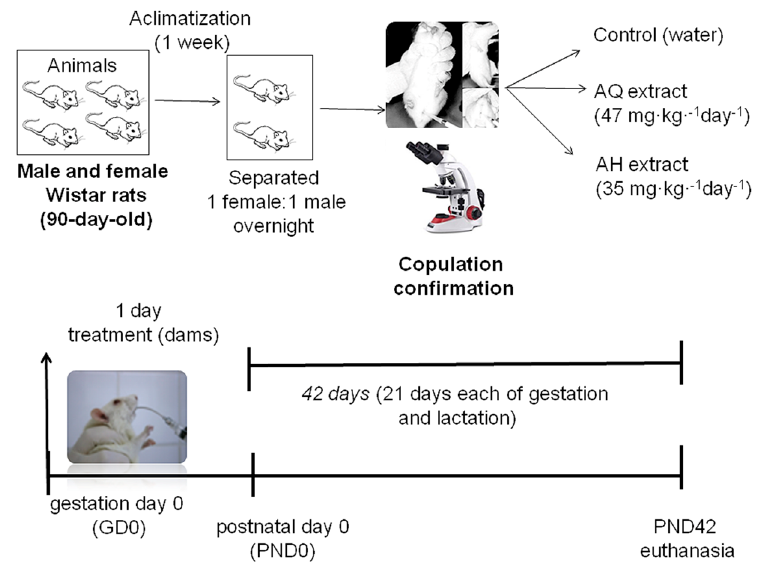
Figure 1. Workflow timeline and experimental design.